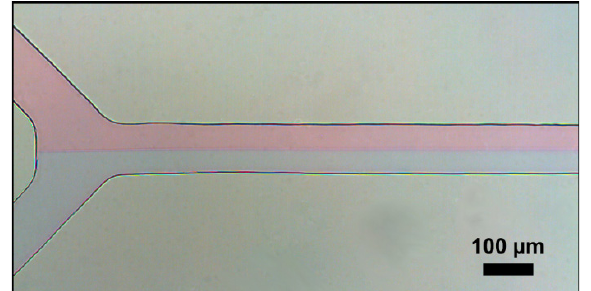
Figure 7. Optical image of laminar flow in a y-shaped